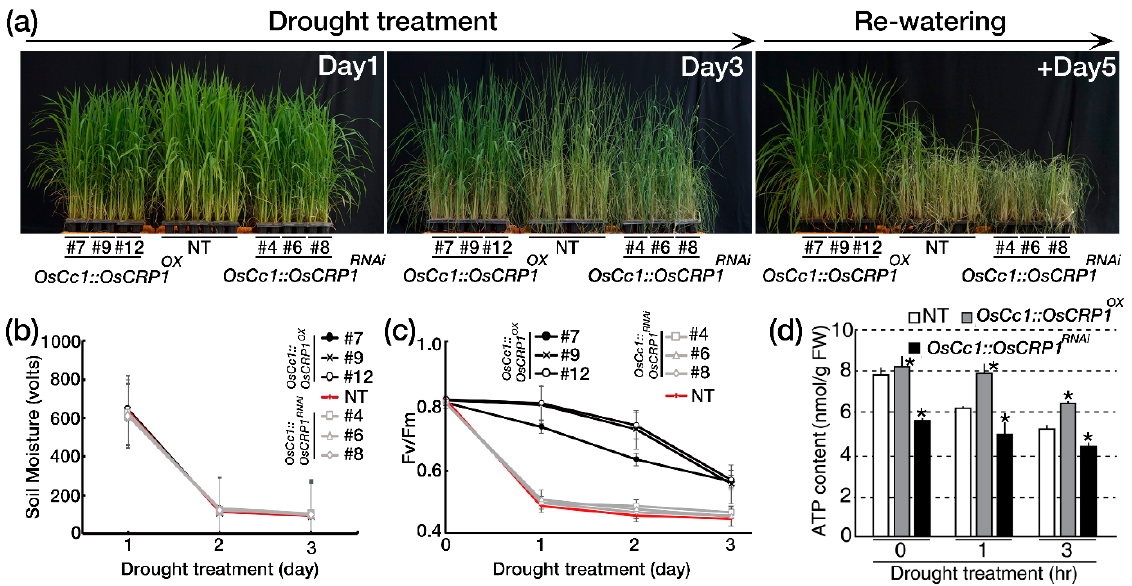
Figure 5. OsCRP1 overexpression in rice confers drought tolerance. ( a ) Phenotypes of OsCc1::OsCRP1 OX and OsCc1::OsCRP1 RNAi transgenic rice plants under drought stress at the vegetative stage. Three independent homozygous OsCc1::OsCRP1 OX and OsCc1::OsCRP1 RNAi lines and NT control plants were grown in soil for 5 weeks and exposed to drought for 3 days, followed by re-watering. ( b ) Soil moisture in the pots exposed to drought treatment at the indicated time points. Values are the means ± SD ( n = 10). ( c ) Chlorophyll fluorescence (Fv/Fm) of OsCc1::OsCRP1 OX and OsCc1::OsCRP1 RNAi transgenic rice plants and NT plants during a 3-day drought treatment. Fv/Fm values were measured in the dark to ensure sufficient dark adaptation. Data are shown as the mean ± SD ( n = 30). ( d ) ATP contents in leaves of the OsCc1::OsCRP1 OX , NT and OsCc1::OsCRP1 RNAi plants under drought stress conditions. Five-week-old plants were transferred to water for 2 days prior to drought treatments. Air-dried plants were taken at 1 and 3 h of treatment to compare ATP contents. Ten plants were used for each line. Data bars represent the mean ± SD of three biological replicates, each of which had two technical replicates. Asterisks indicate significant differences compared with NT (* p < 0.05, One-way ANOVA).